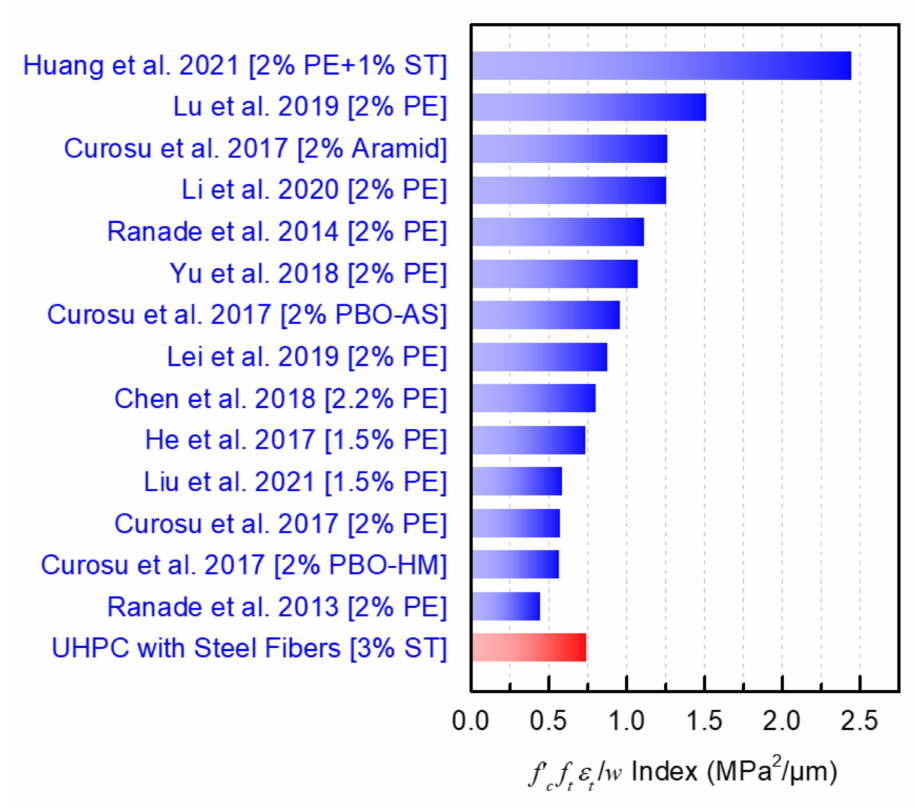
Figure 5. Summary of f’ c f t ε t / w indices of strain-hardening UHPC with synthetic